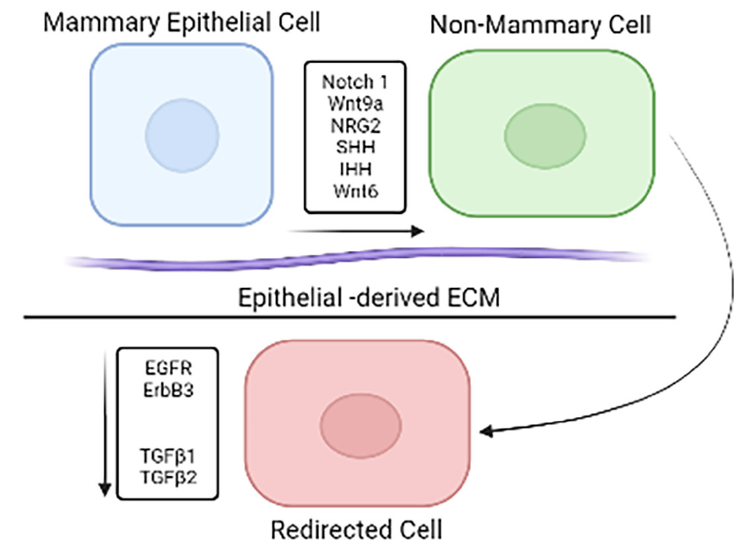
Figure 3. Mammary epithelial cells induce gene expression changes.